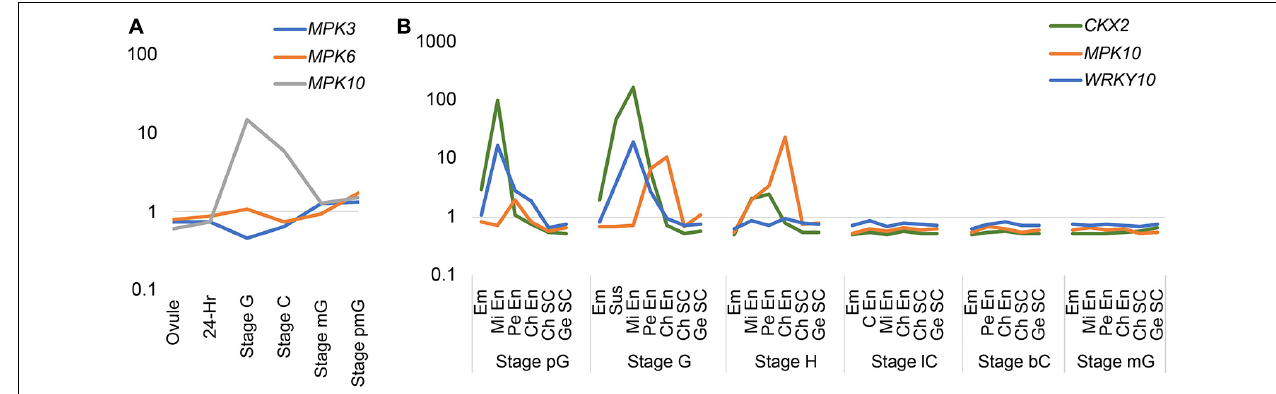
FIGURE 1 | The expression pattern of MPKs , WRKY10 , and CKX2 in transcriptome of LCM datasets. (A) The expression patterns of group A MPKs during life cycle. 24-h, 24-h seed; Stage G, globular stage seed; Stage C, cotyledon stage seed; Stage mG, mature green seed; Stage pmG, post-mature green seed. (B) The expression pattern of MPK10 , WRKY10 , and CKX2 during endosperm development based on LCM dataset. Em, embryo; En, endosperm; Mi En, micropylar endosperm; Pe En, peripheral endosperm; C En, cellularized endosperm; Ch En, chalazal endosperm; Ch SC, chalazal seed coat; Ge SC, general seed coat; pG, pre-globular stage; G, globular stage; H, heart stage; lC, linage cotyledon stage; bC, bent cotyledon stage; mG, mature green stage. The normalized intensity is showed as log scale ( Y -axis). This figure is based on data from public available dataset (NCBI GEO; accession number